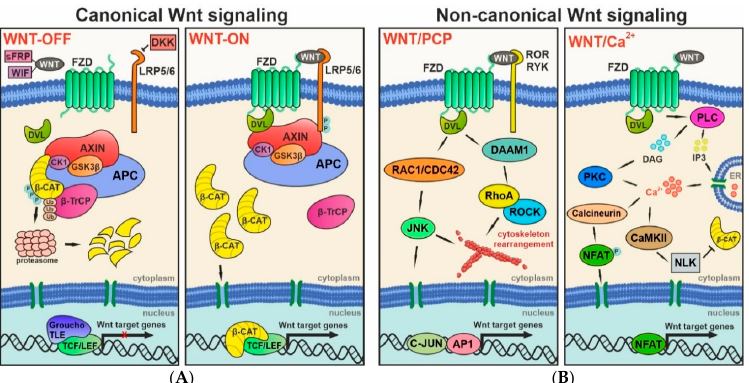
Figure 1. Overview of the canonical and non-canonical Wnt signaling pathways. ( A ) β -catenin-dependent signaling is activated by binding of a canonical Wnt ligand to the frizzled (FZD) receptor and the low-density lipoprotein receptor-related protein 5 / 6 (LRP5 / 6) co-receptor. Subsequently, β -catenin is released from the destruction complex and translocated to the nucleus, where it forms a complex with the T-cell factor / lymphoid enhancer-binding factor (TCF / LEF) proteins in order to activate transcription of the Wnt-responsive genes; ( B ) Activation of the non-canonical— β -catenin-independent—Wnt signaling branches influences cell properties and results in transcription of alternative Wnt target genes. In addition, in some cells non-canonical signaling inhibits β -catenin-mediated